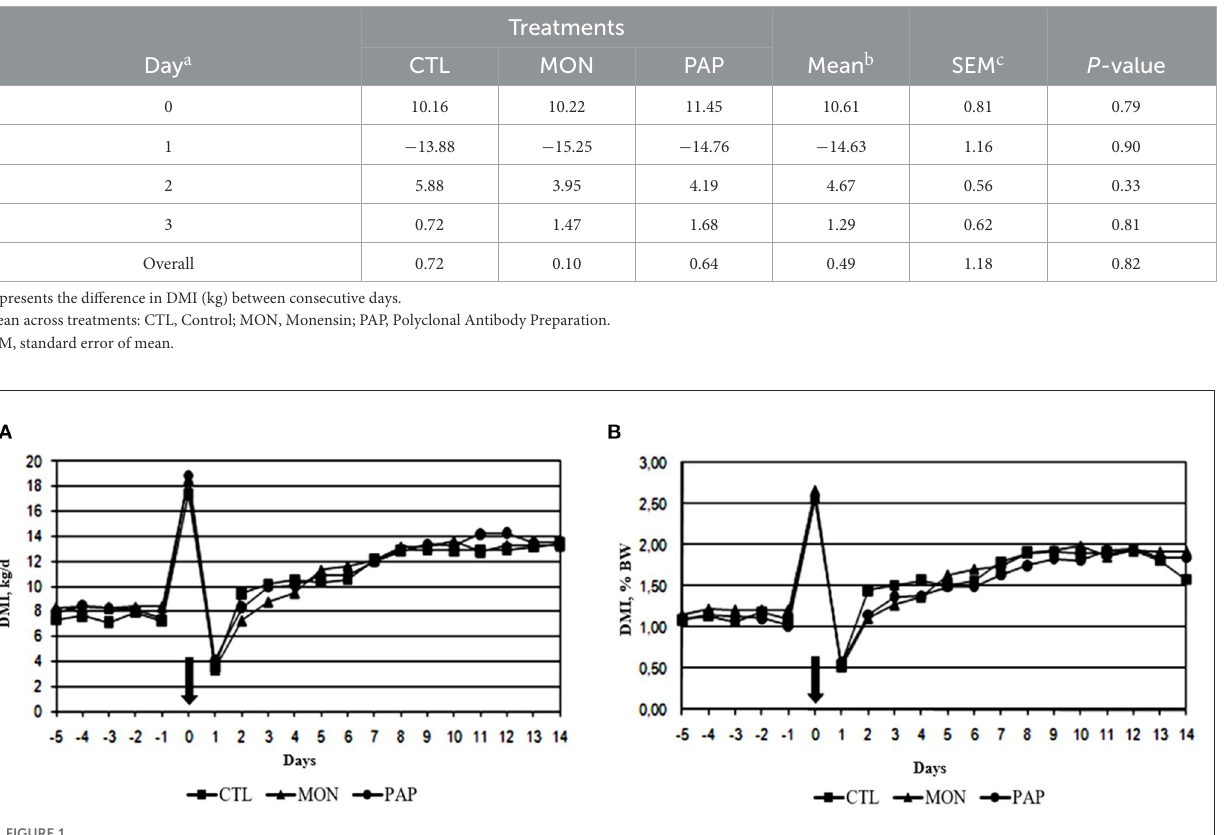
FIGURE1 Dry matter intake expressed in kg [DMI, (A) ] and as a percentage of body weight [DMI %BW, (B) ] of cows induced to ruminal acidosis. The bold arrow represents the change from the 100% forage diet to the 74% concentrate diet containing the